Question: Write a single sentence explaining what this figure depicts.
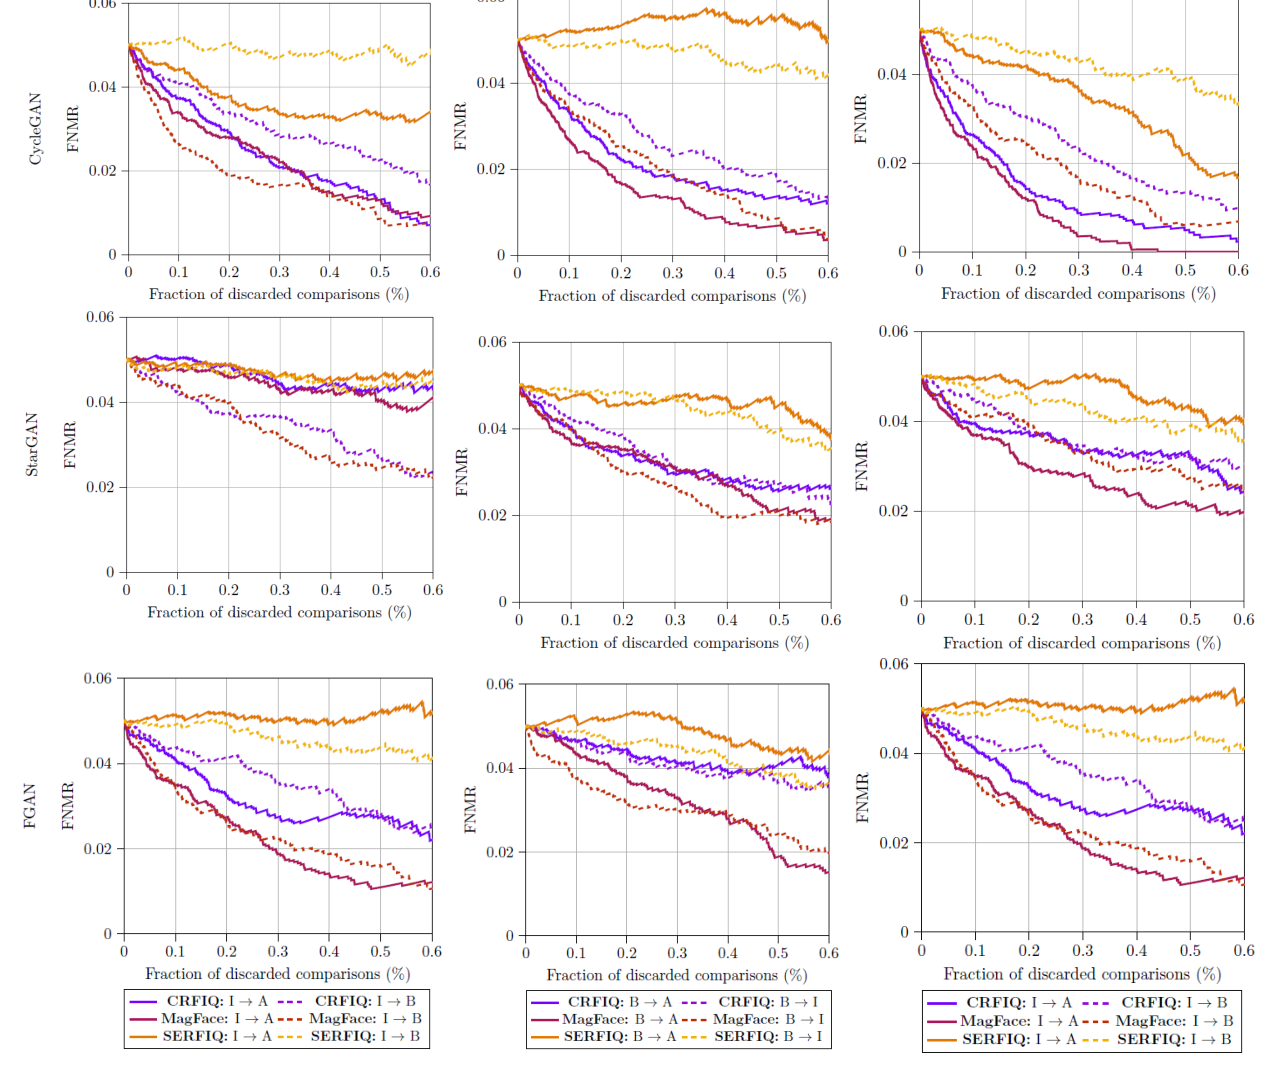
Answer: EDC plot: performance evaluation of ArcFace on CRFIQA, MagFace, and SERFIQ with CycleGAN (first row), StarGAN (second row), and FGAN (third row).